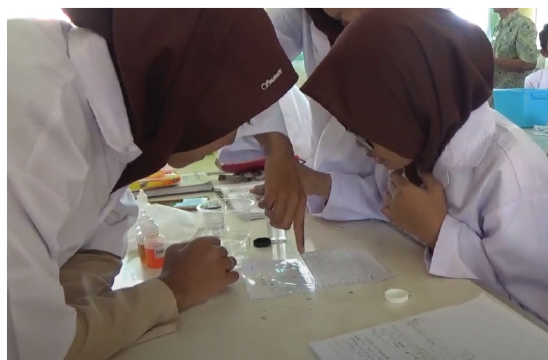
Figure 9. Group collaborative work and their interactions in the process of counting and observing color changes